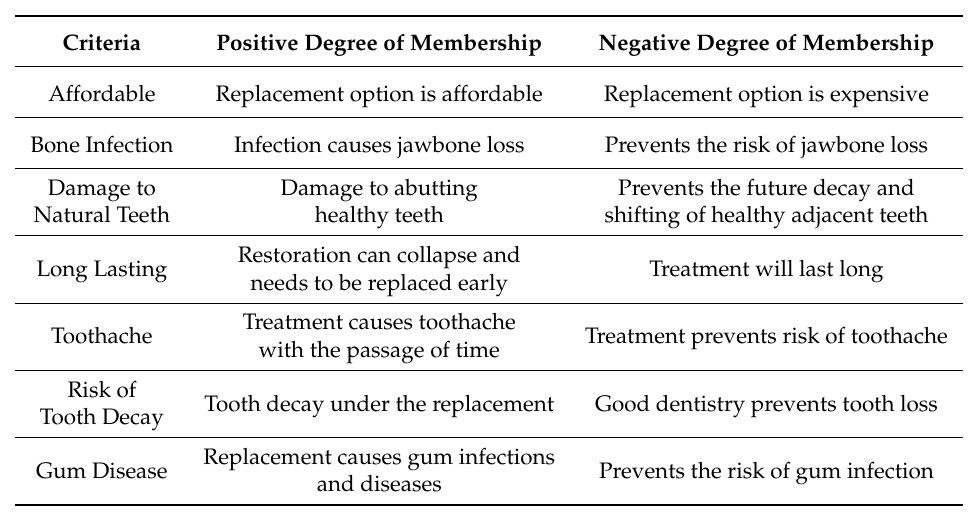
Table 10. Bipolar fuzzy decision matrix.